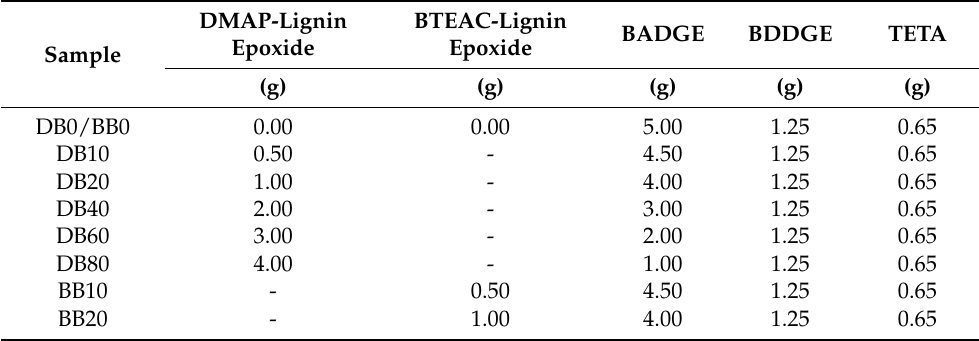
Table 3. The formulation adopted for the preparation of a series of the lignin epoxide/BADGE composite resin samples with different ratios of the lignin epoxide to